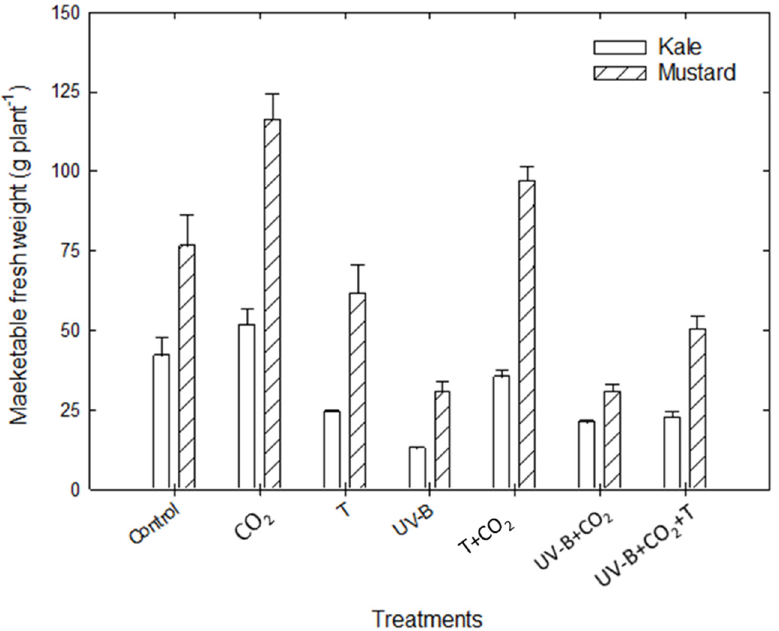
Figure 3. Impact of CO 2 concentration (control, 400 µ molmol − 1 and +CO 2 , 720 µ mol mol − 1 ), elevated temperatures (25/17 °C and 35/27 °C (day/night)), and UV-B radiation (control, 0 and +UV-B, 10 kJ m − 2 d − 1 ), and their interactions on marketable fresh weight for kale and mustard. Bars indicate standard errors of the mean.